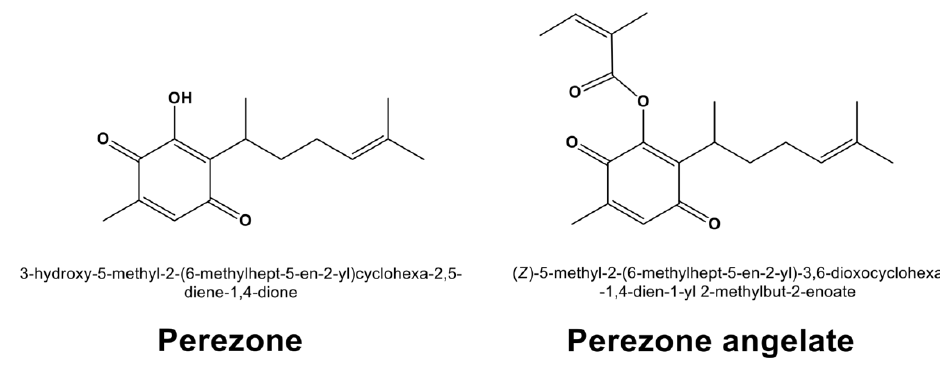
Figure 1. Chemical structures of perezone and perezone angelate.